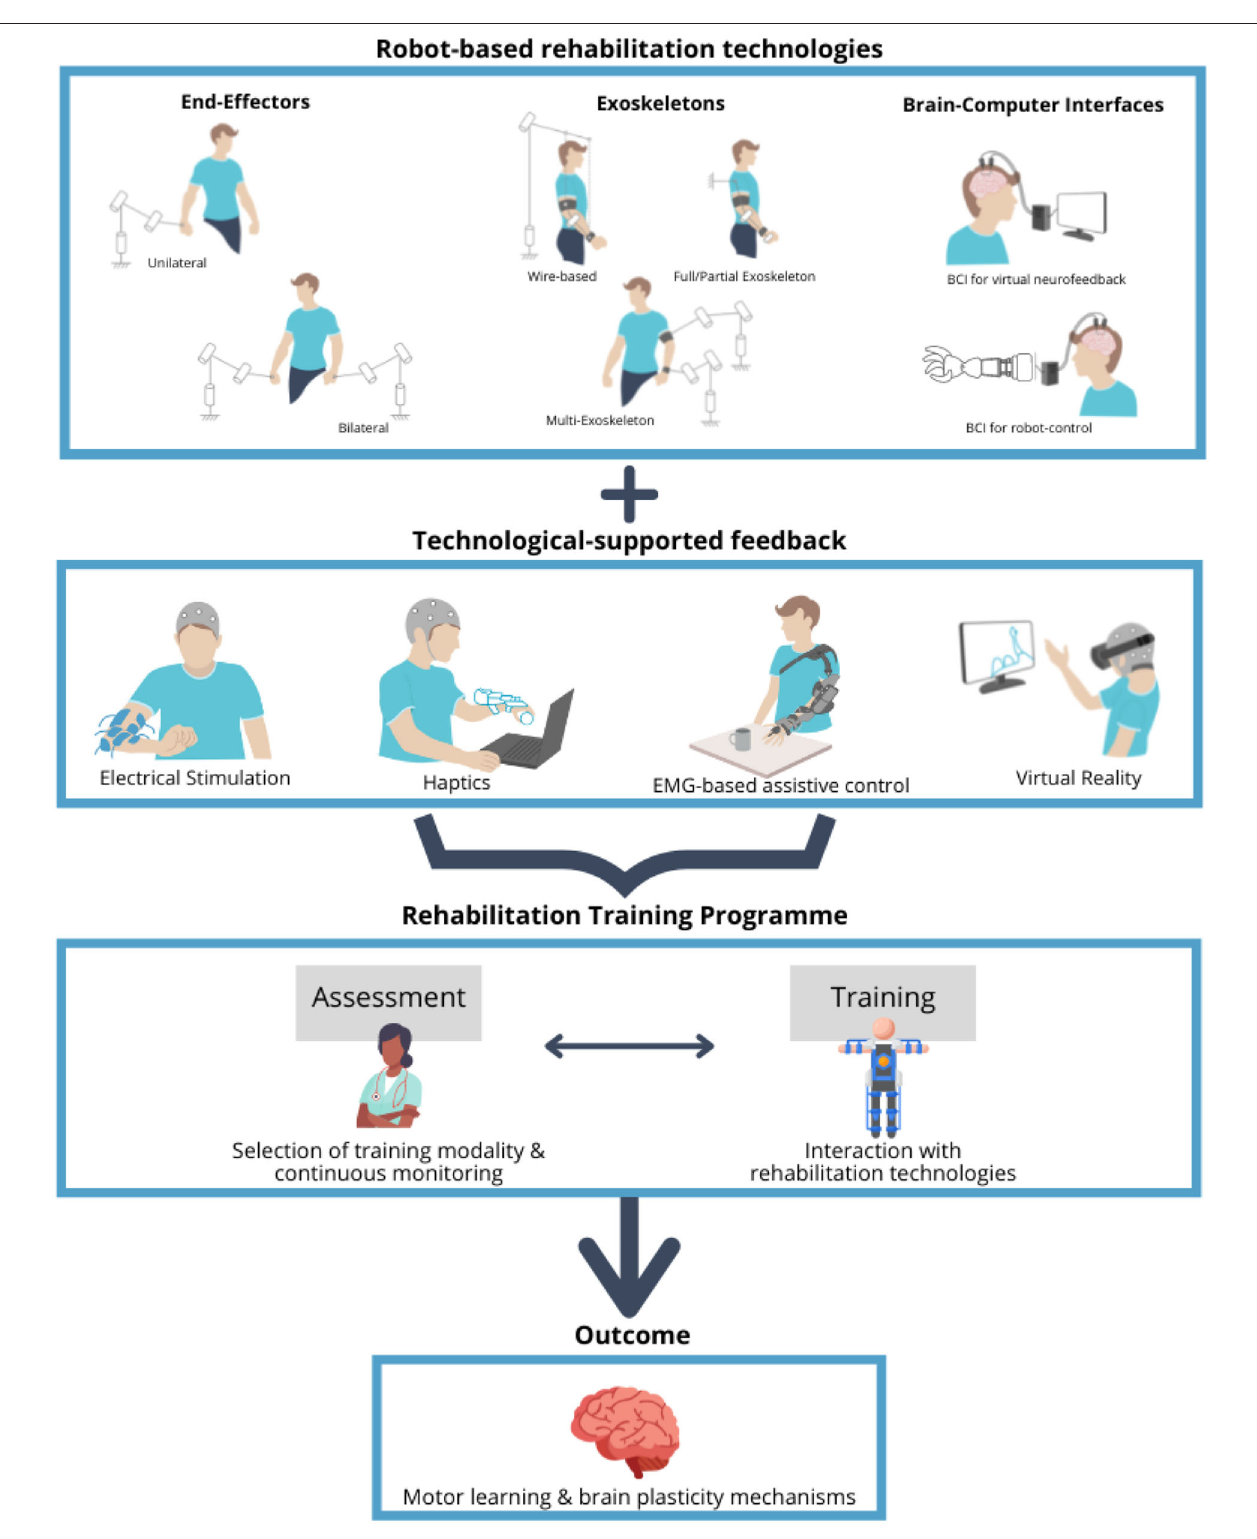
FIGURE 2 | Overview of the robot-based rehabilitation technologies, feedback modalities, and rehabilitation training program. Robot-based rehabilitation technologies (top panel), which include the end-effector robots, exoskeletons, and brain–computer interfaces (BCIs), are used in combination with the feedback modalities